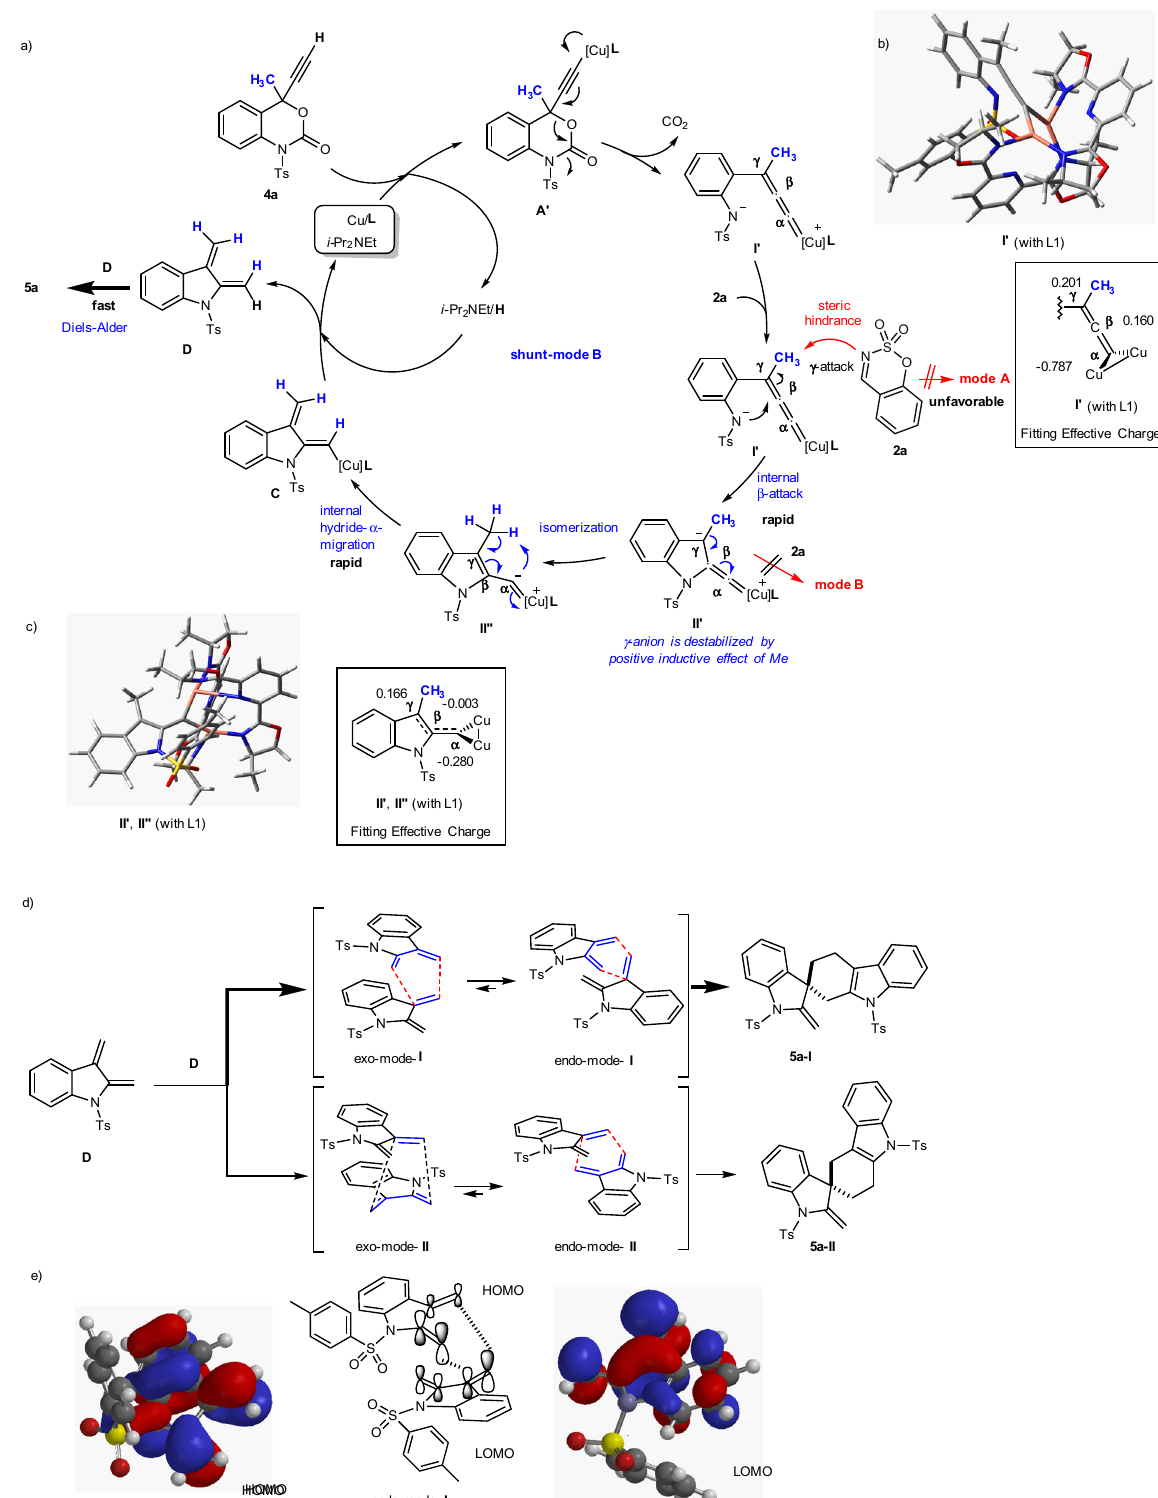
Fig. 8 Proposed reaction mechanisms. a A Cu-catalyzed catalytic cycle for the decarboxylative annulation of 4a (with 2a ) (shunt-mode B ). b Optimized geometry of I ′ (with L1 ) and calculated atomic charges. c Optimized geometry of II' ( II ′′ ) (with L1 ) and calculated atomic charges. d Regioselective formation of spiro-carbazole-indoline 5a (2C) rather than 5a (3C) via an endo-preferential Diels − Alder reaction. e HOMO (diene)-LUMO (dieneophile)- controlled Diels − Alder